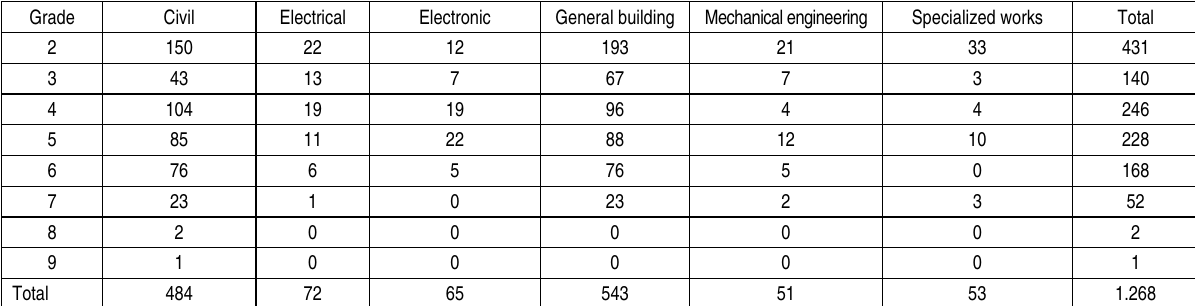
Table 1. CIDB grades of construction companies in Limpopo Province